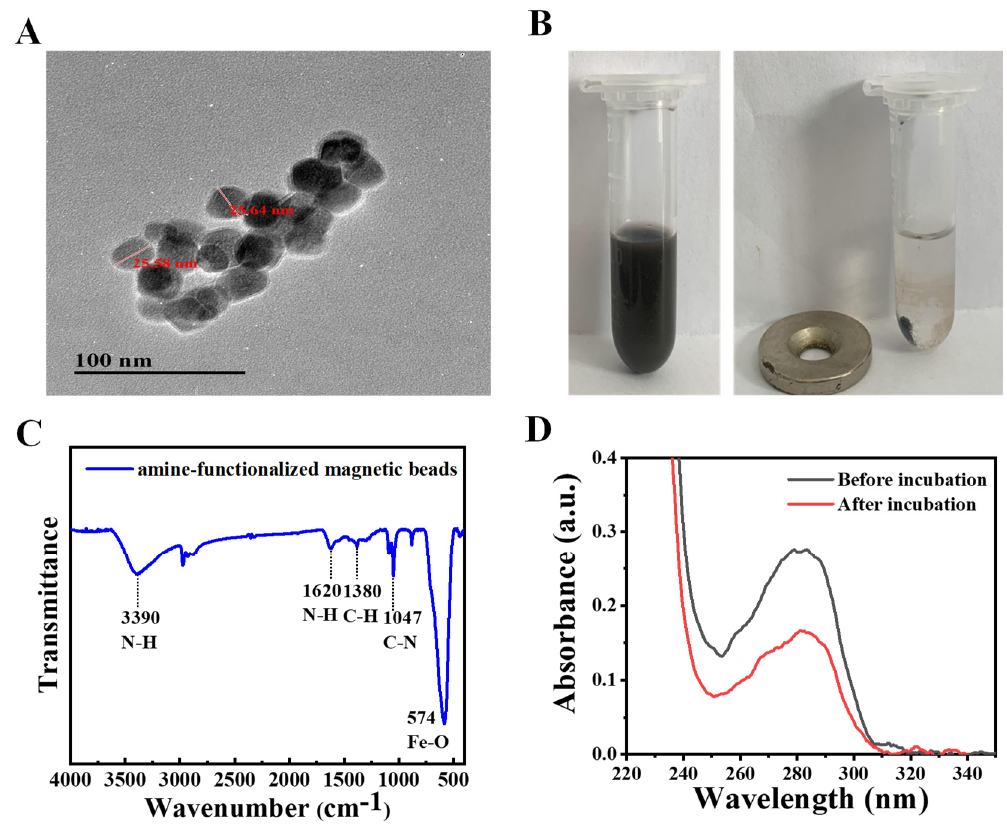
Figure 3. ( A ) Transmission electron microscope (TEM) image of amine-functionalized magnetic beads. ( B ) Photograph of amine-functionalized magnetic beads in aqueous solution (magnet absence and presence). ( C ) Fourier transform infrared (FT-IR) spectra of amine-functionalized magnetic beads. ( D ) Ultraviolet-visible (UV-vis) spectra of biotin-modified aptamer solution before and after incubation with avidin-functionalized magnetic